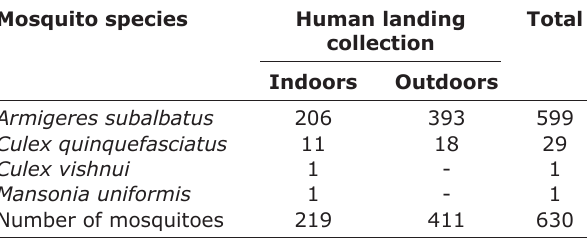
Table-1: Species diversity of mosquitoes caught in Lubuk Pauh village by human landing collection method. Mosquito species